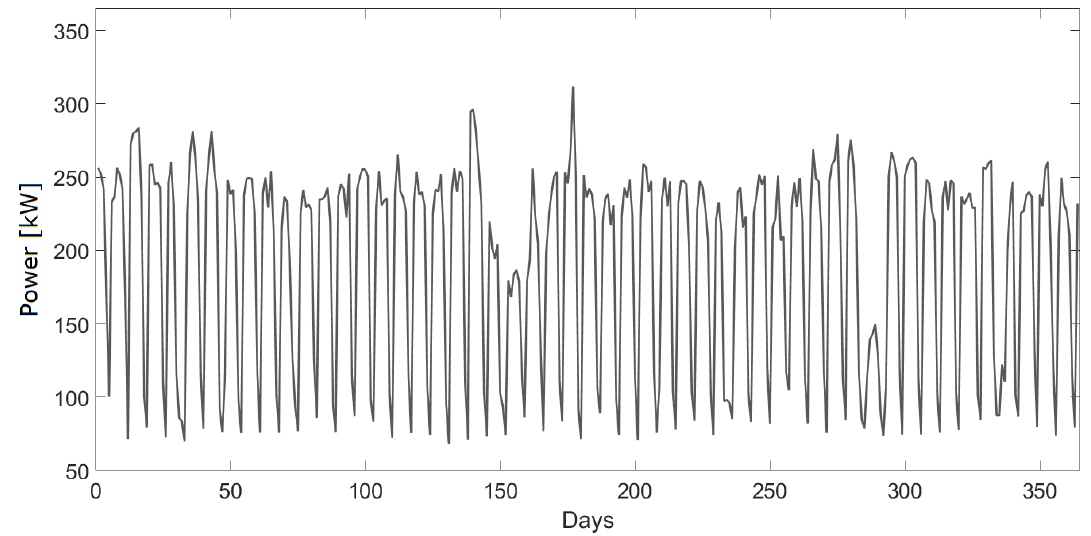
Figure 6. Deseasonalized electricity consumption: Universidad Politécnica Salesiana (9 March 2017–8 March